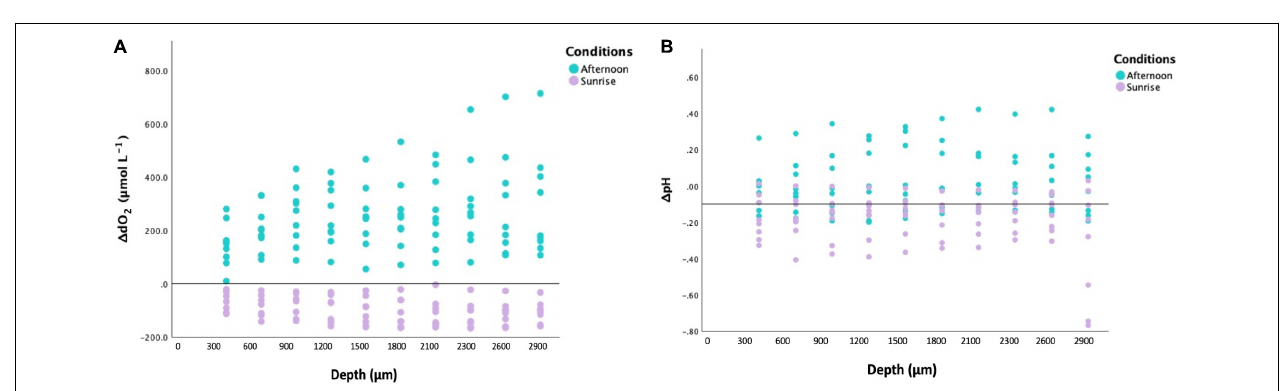
FIGURE 2 | (A) Boxplot indicating the levels of (cid:49) d O 2 (to ambient levels in µ mol L − 1 ) in Cassiopea sp. oral arms for the two conditions (afternoon, in turquoise, and sunrise, in lilac; n = 3). The difference between the two conditions was highly statistically significant (LMMs, p < 0.001, Table 1 ). The white horizontal line in the center of boxes represents the median value of data, the edges of the boxes are quartile and error bars are the extreme. (B) Boxplot indicating the levels of (cid:49) pH (to ambient level) in Cassiopea sp. oral arms for the two conditions (afternoon, in turquoise, and sunrise, in lilac; n = 3). The difference between the two conditions was statistically significant (LMMs, p = 0.012, Table 1 ). The white horizontal line in the center of boxes represents the median value of data, the edges of the boxes are quartile and error bars are the extreme.